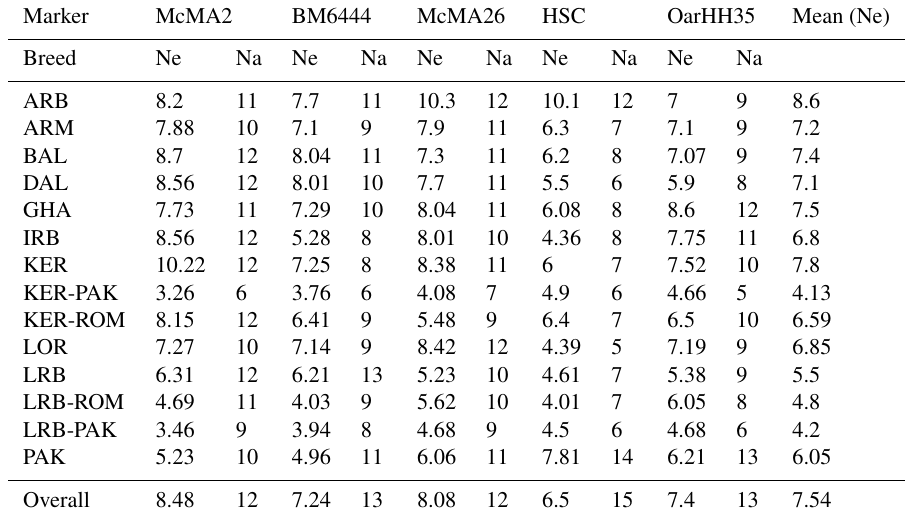
Table 2. The number of actual alleles (Na) and effective alleles (Ne) for different combinations of locus–population and for each population. Marker